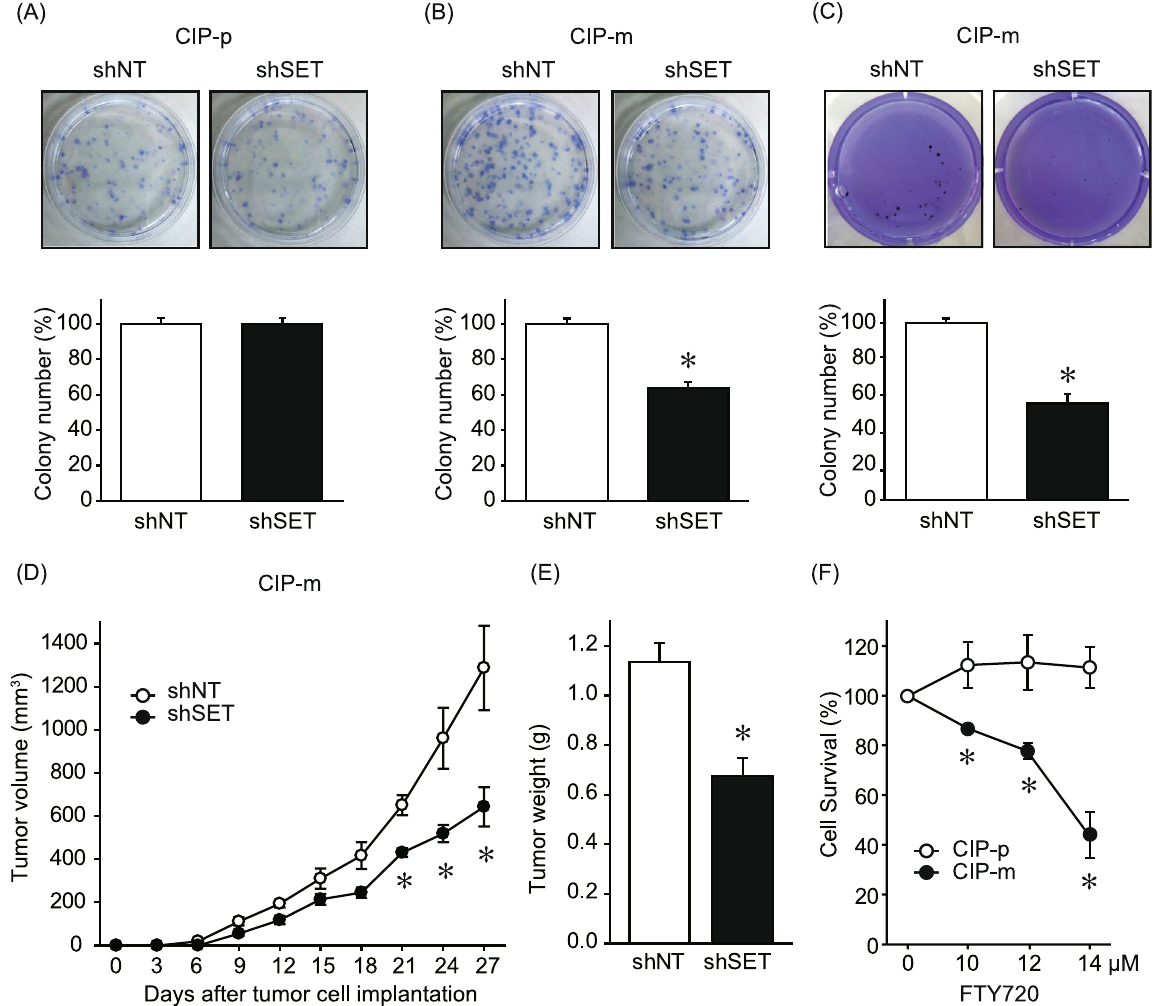
Figure 3. SET knockdown suppressed colony formation ability and anchorage-independent cell growth of canine mammary tumor cells. ( A and B ) Colony formation ability was examined for CIP-p ( A ) and CIP-m ( B ) expressing shNT or shSET. Colony numbers of shSET expressing cells were normalized to colony numbers of shNT expressing cells as 100%. Quantitative data from 3 independent experiments performed duplicate are shown. * P < 0.05 vs. shNT. ( C ) Soft agar colony formation assay was performed to examine the anchorage- independent growth of CIP-m cells expressing shNT or shSET. Colony numbers of shSET expressing cells were normalized to colony numbers of shNT expressing cells as 100%. Quantitative data from 3 independent experiments performed duplicate are shown. * P < 0.05 vs. shNT. ( D and E ) In vivo tumor growth of CIP-m expressing shNT or shSET was examined in a xenograft model. Tumor growth was monitored by measuring tumor volume ( D ). Tumors were harvested after 35 days growth, and tumor weights were measured ( E ). N = 7. * P < 0.05 vs. shNT. ( F ) Cell viability of CIP-p and CIP-m cells were analyzed by CCK8 after 48 hr treatment with FTY720. Cell viabilities were normalized to non-treated control of each cell lines as 100%. Quantitative data from 2 independent experiments performed duplicate are